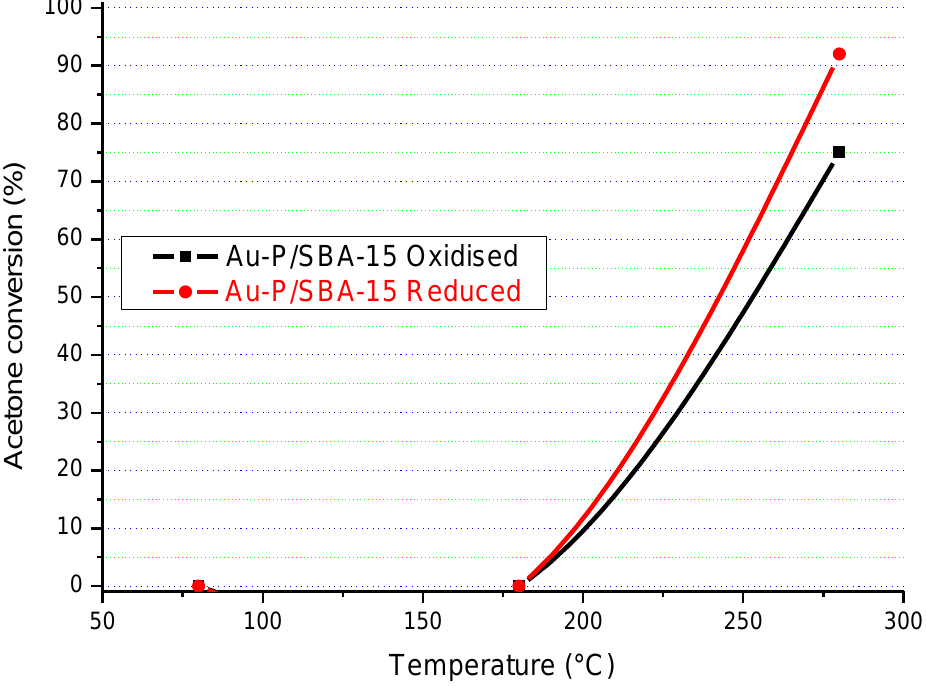
Figure 19. Complete oxidation of acetone over oxidised and reduced Au-P/SBA-15 samples. Two series of measurements were performed. The first series was performed over the catalyst’s samples previously subjected to a flow of 60 mL/min 5% hydrogen in Ar at 500 ◦ C for one hour (so called “Reduced”) and the second series was performed over the as-synthesised samples (so called “Oxidised”). The pre-treatment in hydrogen led to the reduction of -OH groups still present on the samples’